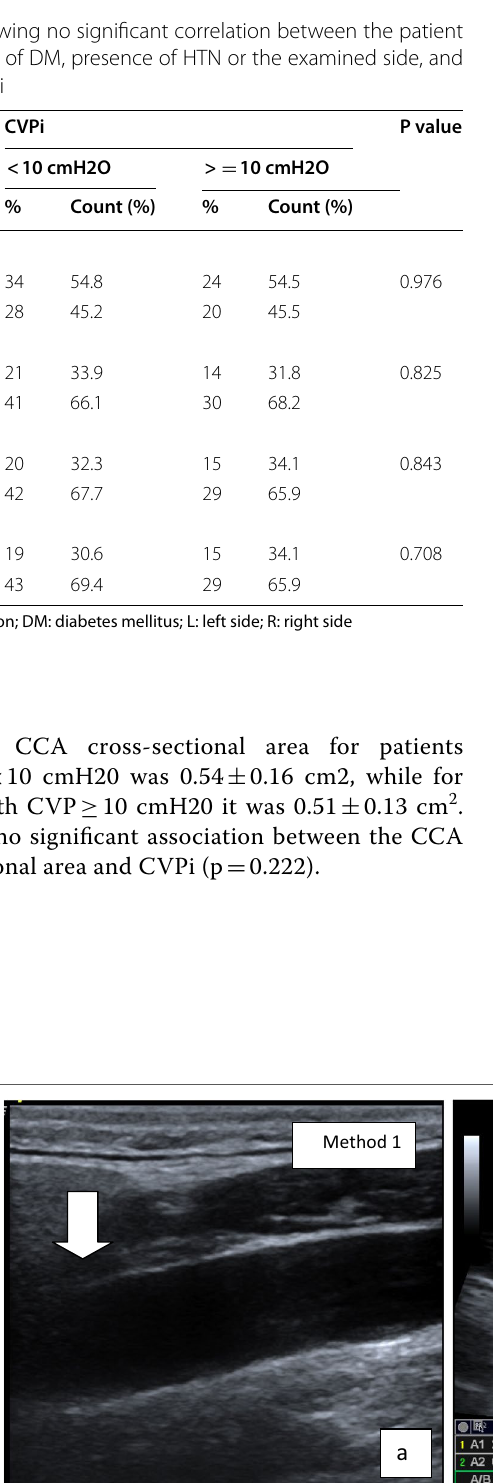
2.46 cm 2 ) and the CCA area ( 0.82 cm 2 ) and the ratio ( 3.01) = = =